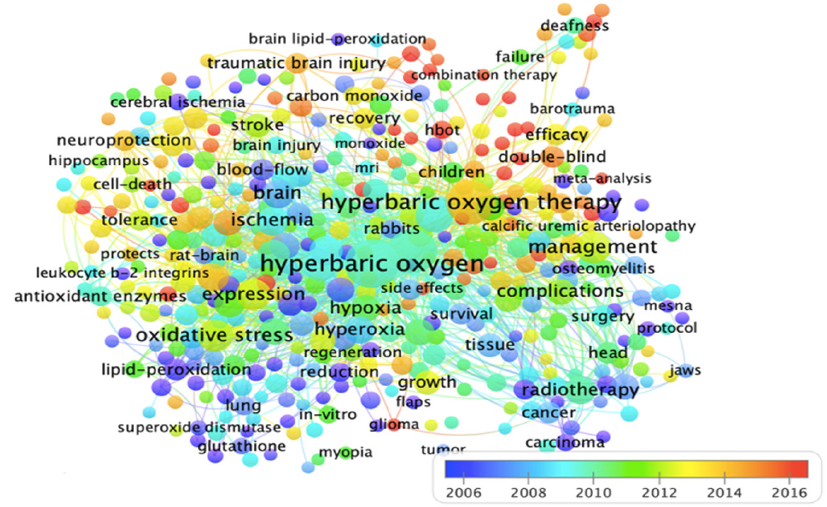
Figure 10. Overlay visualization of keyword co-occurrence. Co-occurrence network analysis was used to examine the relationships in and structure of HBOT research (Figure